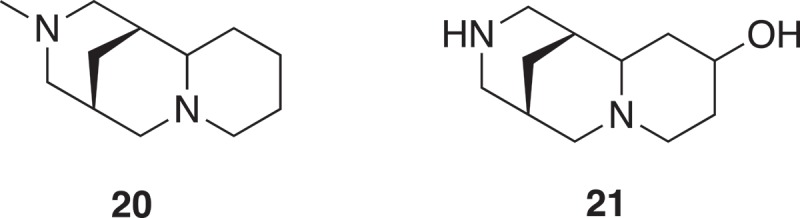
A fragment (20) of a cluster of 85 members and is a substructure of 53 natural products such as sparteine, fragment (21) is the cluster center of the 85 member cluster and is a substructure of bapitifoline.